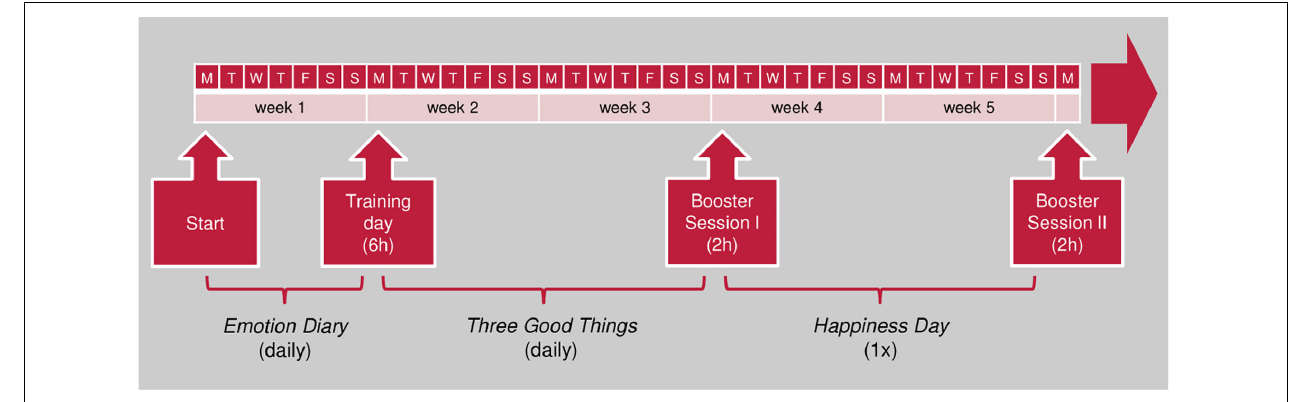
FIGURE 1 | Training